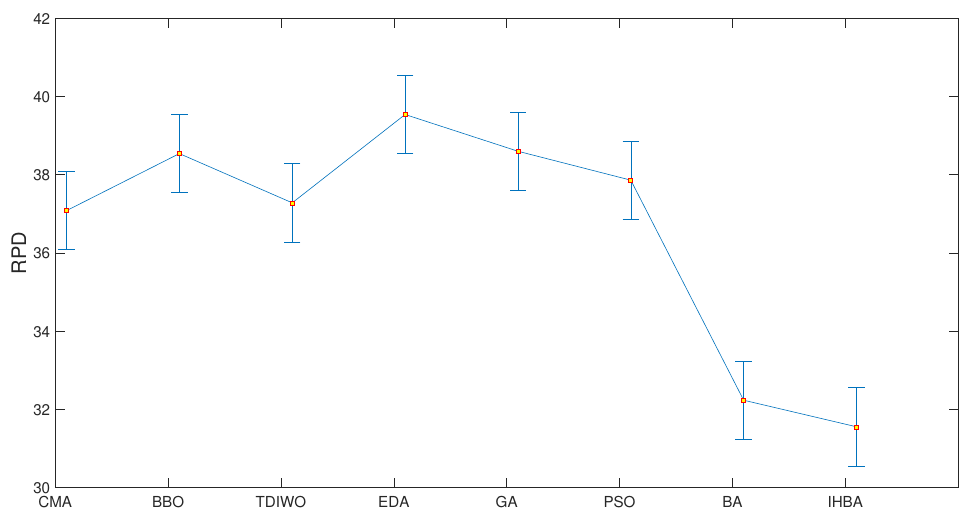
Figure 3. Mean plot and 95% LSD interval of the bat algorithm at C = 60.